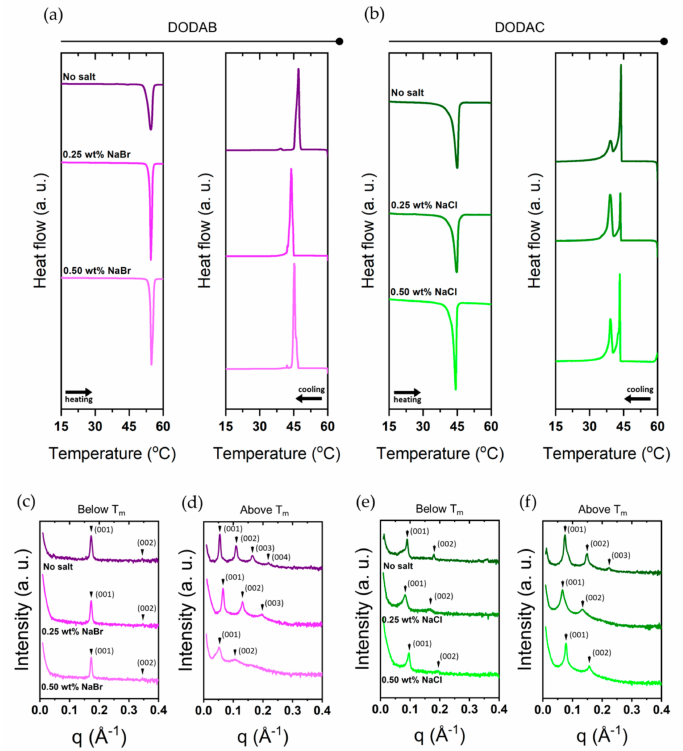
Figure 7. Thermal and packing characterisation of 35 wt% DODAB and 35 wt% DODAC in the presence of electrolytes. ( a , c , d ) DODAB in the presence of 0.25 wt% (0.08 M) and 0.50 wt% (0.16 M) of NaBr; ( b , e , f ) DODAC in the presence of 0.25 wt% (0.09 M) and 0.50 wt% (0.19 M) of NaCl. SAXS patterns were collected below (25 ◦ C) and above (65 ◦ C) the T m